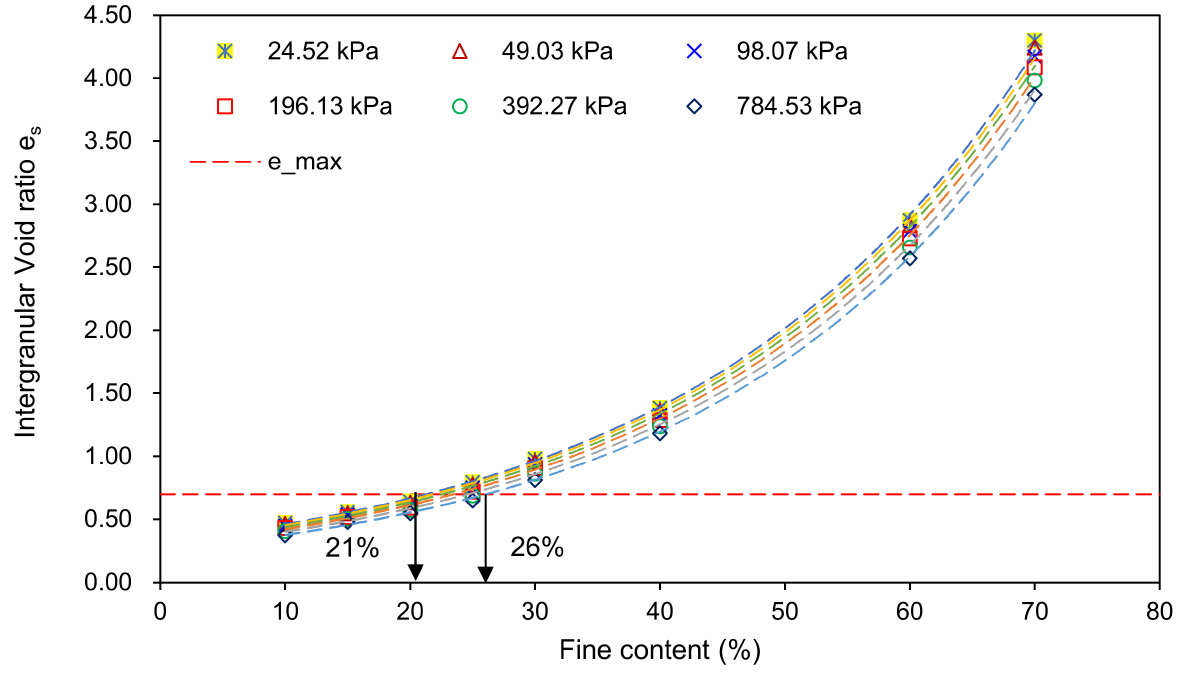
Figure 8. Variations of intergranular void ratio according to fines content.